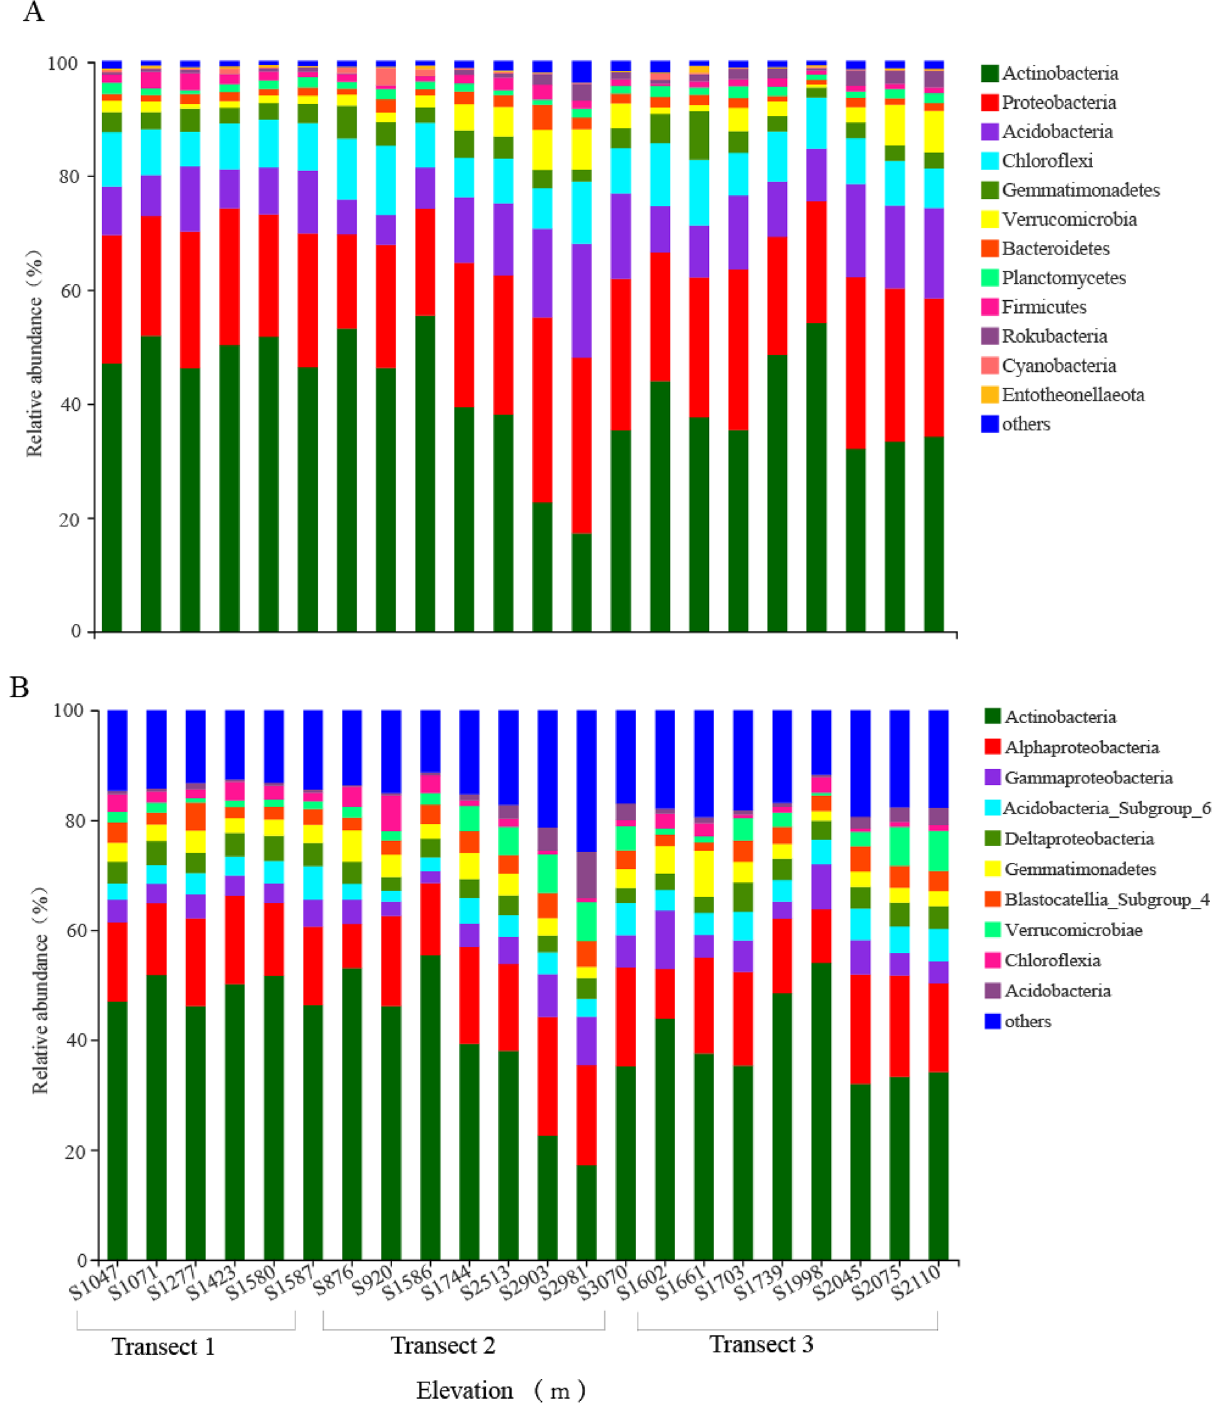
Figure 1. Bacterial community composition variations at the phylum ( A ) and class ( B ) levels in soil samples collected at different levels. These were done in R (v3.3.1, http:// www.R- proje ct. Table 2; Supplementary Fig. 2; P < 0.001), while Acidobacteria , Proteobacteria and Verrucomicrobia showed sig- nificant negative correlations with soil pH and (potential evapotranspiration) PET. Additionally, at the genus level, MAT, PET, and pH were also significantly correlated with bacterial genera (Supplementary Fig. 2).